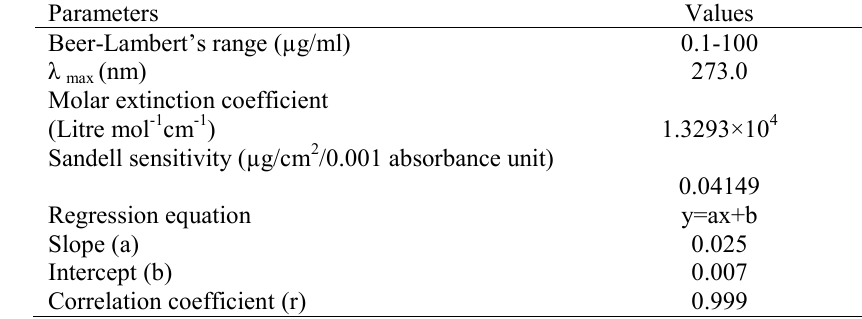
Table 1. Optical characteristics of BST.